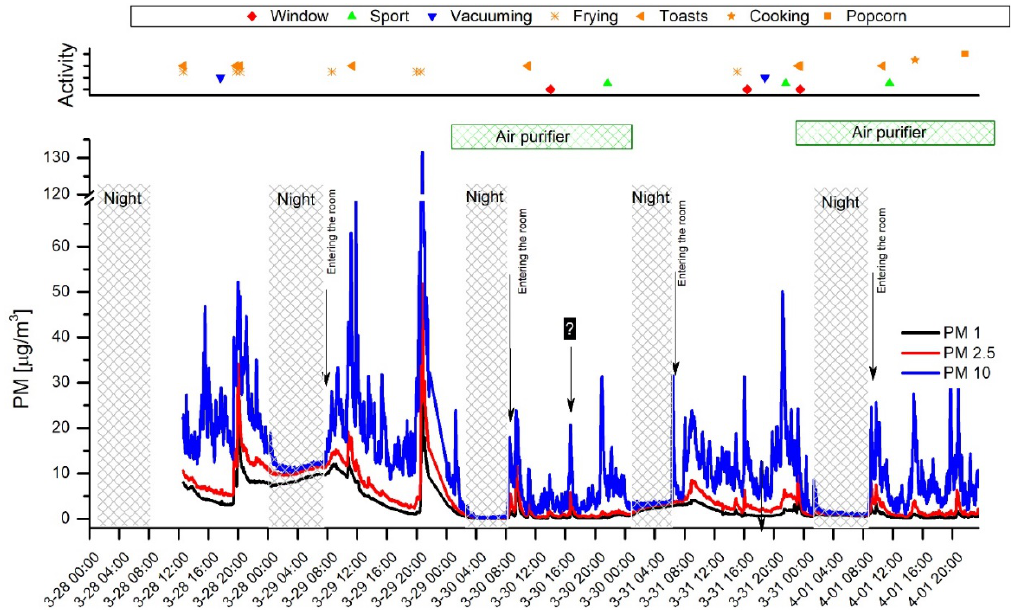
Figure 4. The particulate matter (PM 1 , PM 2.5 , and PM 10 ) timeline records obtained with the OPC-N3. The horizontal green bars represent the periods when the air purifier was used in the room.